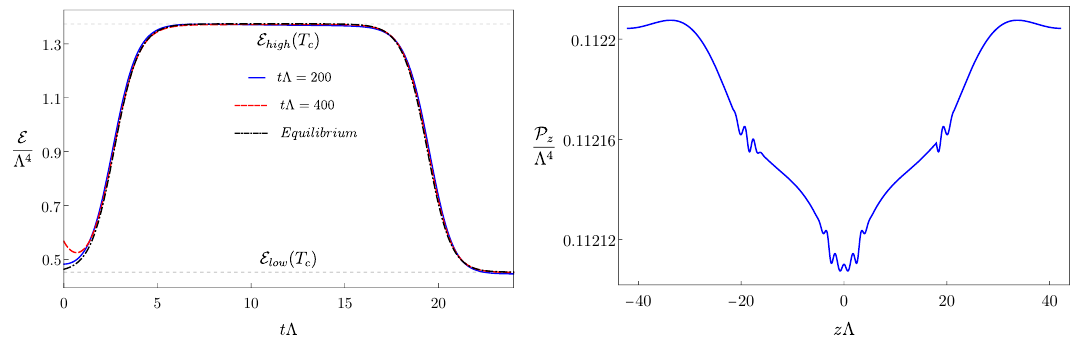
Figure 12 . (Left) Energy profiles (shifted by an appropriate amount) of the domains during the quasi-static phase for the collision of figure 9. (Right) Snapshot of the longitudinal pressure distribution at t Λ = 350